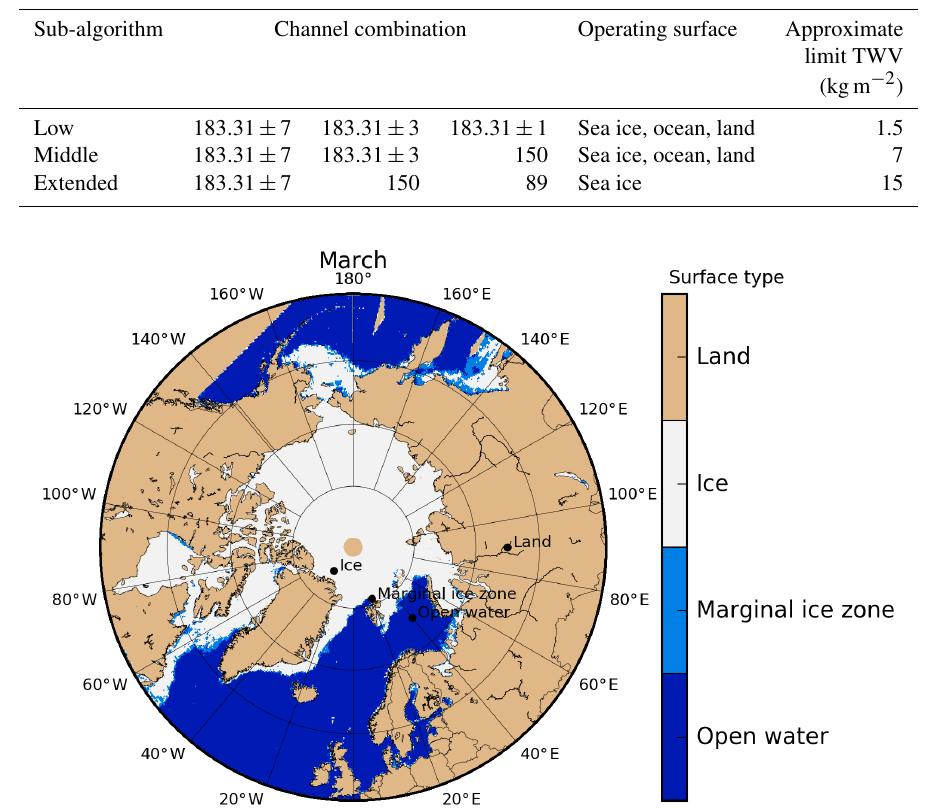
Table 3. Characteristics of the different sub-algorithms of the AMSU-B–MHS TWV retrieval. The channel combination is described with AMSU-B frequencies, and the MHS retrieval uses the corresponding frequencies.